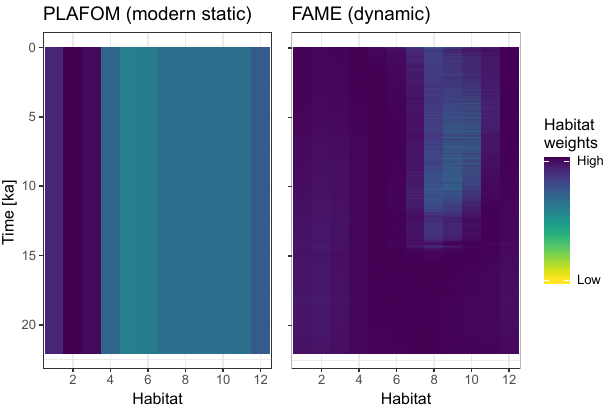
Figure 4. A comparison of static and dynamic monthly weights generated by PLAFOM driven by modern climatology, and FAME driven by the input climate